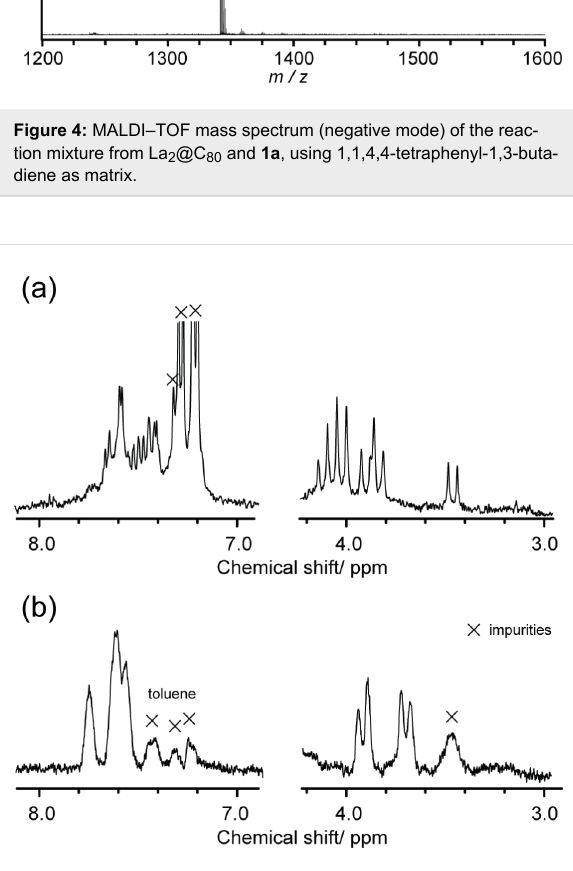
Figure 5: 1 H NMR spectra of (a) the mixture of 3a and 4a in C 2 D 2 Cl 4 at 248 K, and (b) isolated 4a at 230 K, recorded in 300 MHz.